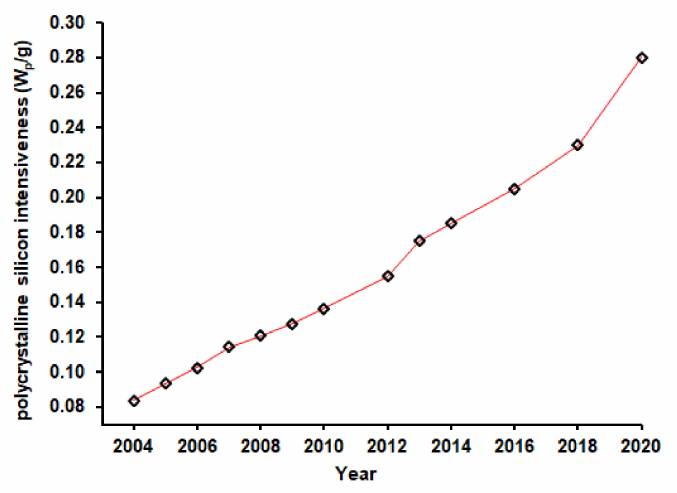
Figure 16. Development of material intensiveness of polycrystalline